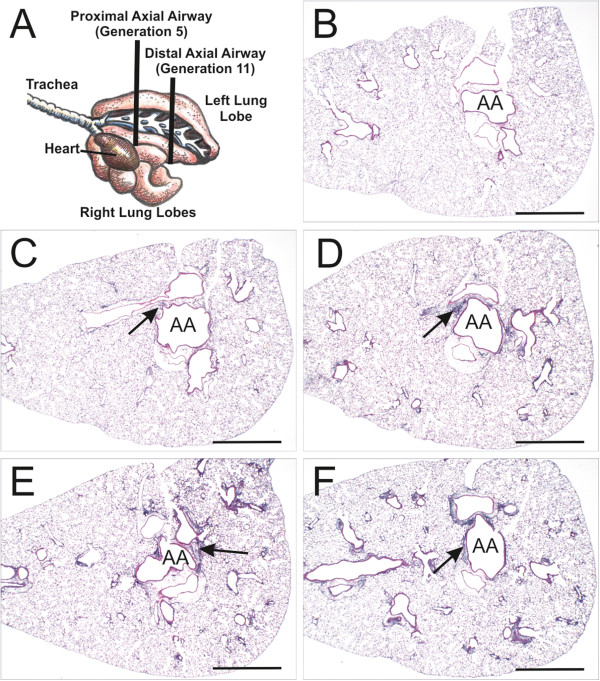
Pulmonary histopathology. A diagram illustrates the locations of transverse tissue sections taken from the left lung lobe for microscopic examination (A). Light photomicrographs of representative lung sections taken at the level of the fifth axial airway (AA) generation and stained with hematoxylin and eosin (B-F). Representative light photomicrographs of a control animal (SAL-mouse; B), OVA-mouse (C) and SNP/OVA-mice with increasing SNP exposure doses (D-F) illustrating peribronchiolar and perivascular mixed inflammatory cell infiltration in OVA- and SNP/OVA-mice (arrows). Greater airway-associated inflammation is present in SNP/OVA-mice exposed to concentrations of 100 and 400 μg SNP (E and F, respectively) compared to the SAL- and OVA-mice. Scale bars = 1 mm.